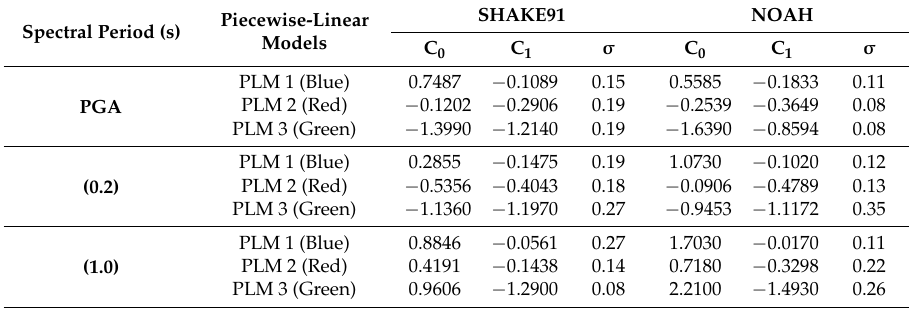
Table 3. Intercept (C 0 ), slope (C 1 ), and standard deviation ( σ ) of the piecewise-linear regression models (PLM) for AF ( f ) vs. S r a ( f )